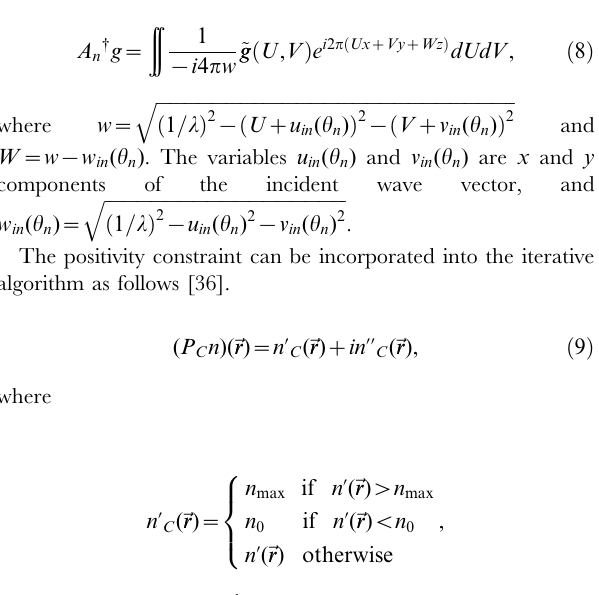
Figure 3. Quantification of chromosomes in live cells. A: Refractive index tomogram of a T84 cell in metaphase measured at 633 nm. B: Dry mass of the entire cell and that of the condensed chromosomes for HT-29 and T84 cells in metaphase. C: Dispersion of chromosomes in eukaryotic cells. Sample images of the refractive index map (cross-section) for a HeLa cell in metaphase measured at (i) 442 nm and (ii) 325 nm, respectively; (iii) a corresponding fluorescence image with nucleic acid stained with Syto13. D: Histogram of the refractive index for chromosomes in HT-29 cells (i, ii) and cytoplasm (iii, iv) at the wavelength of 325 nm (i, iii) and 442 nm (ii, iv), respectively. E: Dispersion parameter estimated from Fig. 3D and Eq. (4). The two distributions are statistically different ( p =0.0133). F: Label-free imaging of cytokinesis in a HeLa cell using RTPM. Cross-sections of the 3-D refractive index map are shown at different time points. Colorbars in A, C and F represent the refractive index.